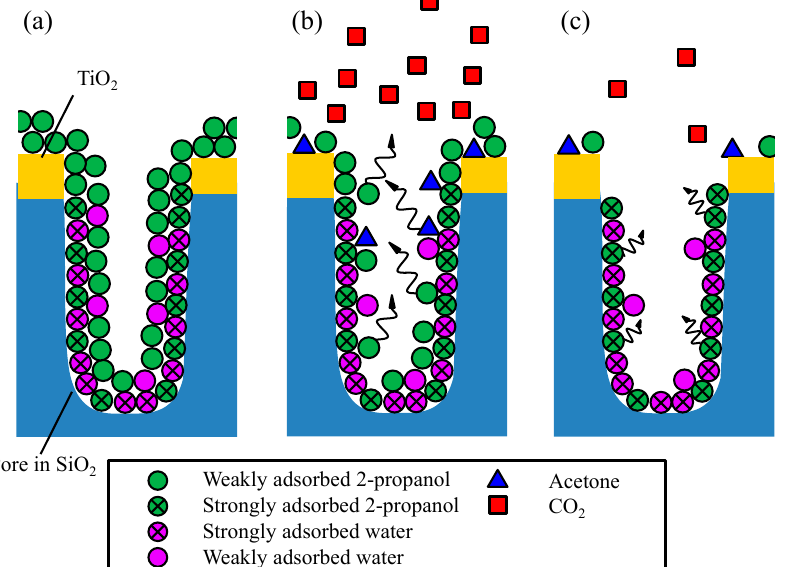
Figure 9. Schematics of ( a ) adsorption, ( b ) early-phase photocatalytic oxidation, and ( c ) late-phase photocatalytic oxidation on the TiO 2 -coated porous glass cloth.